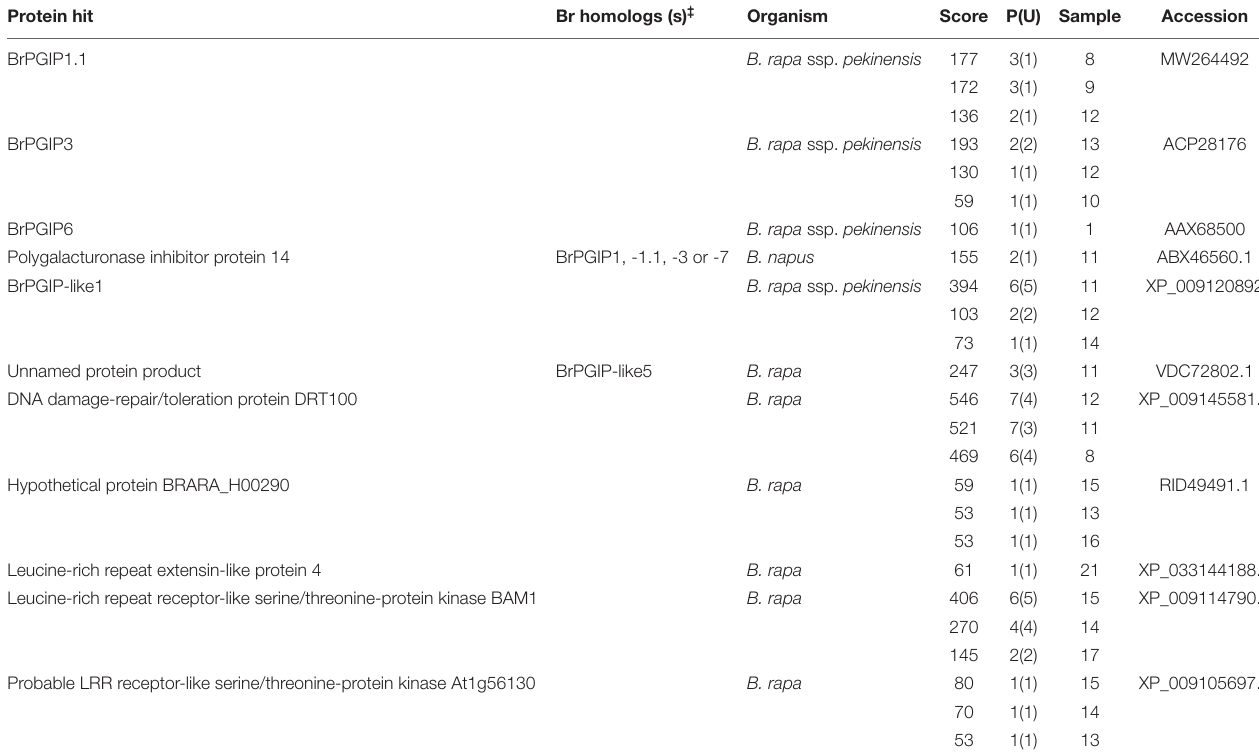
TABLE 1 | Extracellular LRR protein hits from a pull-down assay of PCO_GH28-1 with B. rapa ssp. pekinensis CWPs. Protein hit Br homologs (s) ‡‡‡ Organism Score P(U) Sample